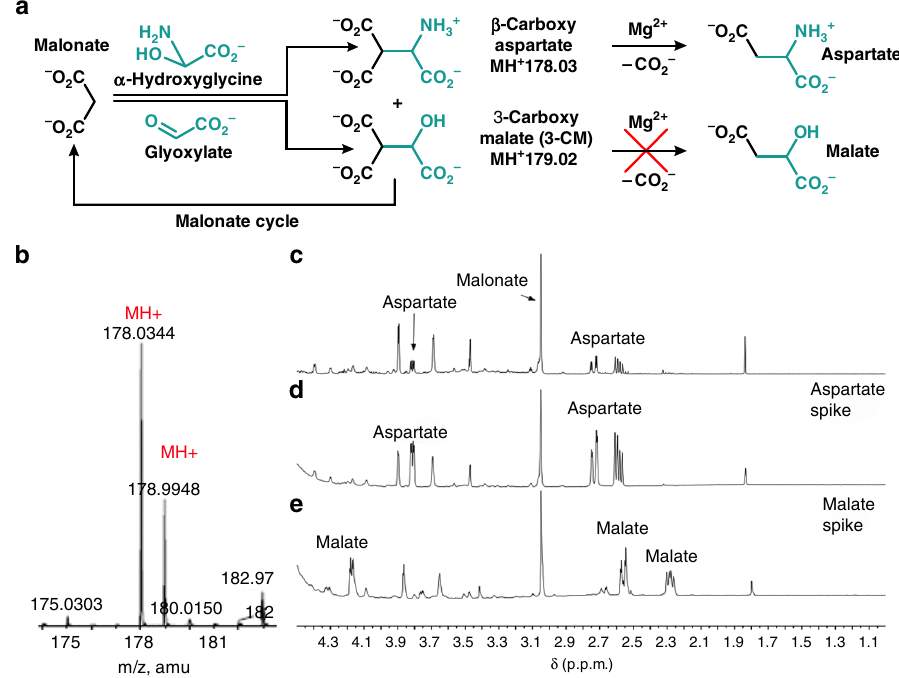
Fig. 7 Aspartate synthesis from malonate, glyoxylate, and ammonia. a Malonate in the presence of a 1:1 mixture of glyoxlate and α -hydroxyglycine produces 3-CM and β -carboxyaspartate. The β -carboxyaspartate selectively decarboxylates to aspartate. b HRMS of a reaction aliquot from 0.5 M malonate and 1 eq. of both α -hydroxyglycine and glyxolate in a pH 6.8 bicarbonate buffer stirred at 23 °C for 5 days. c Subsequent addition of 1 eq. of MgCl 2 and stirring at 50 °C for 5 h produces aspartate, but not malate. d , e Aspartate and malate spikes, respectively, to